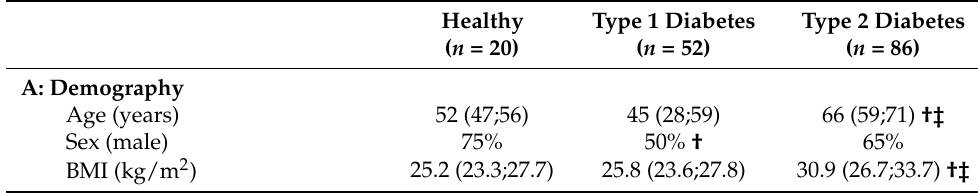
Table 1. Characteristics of